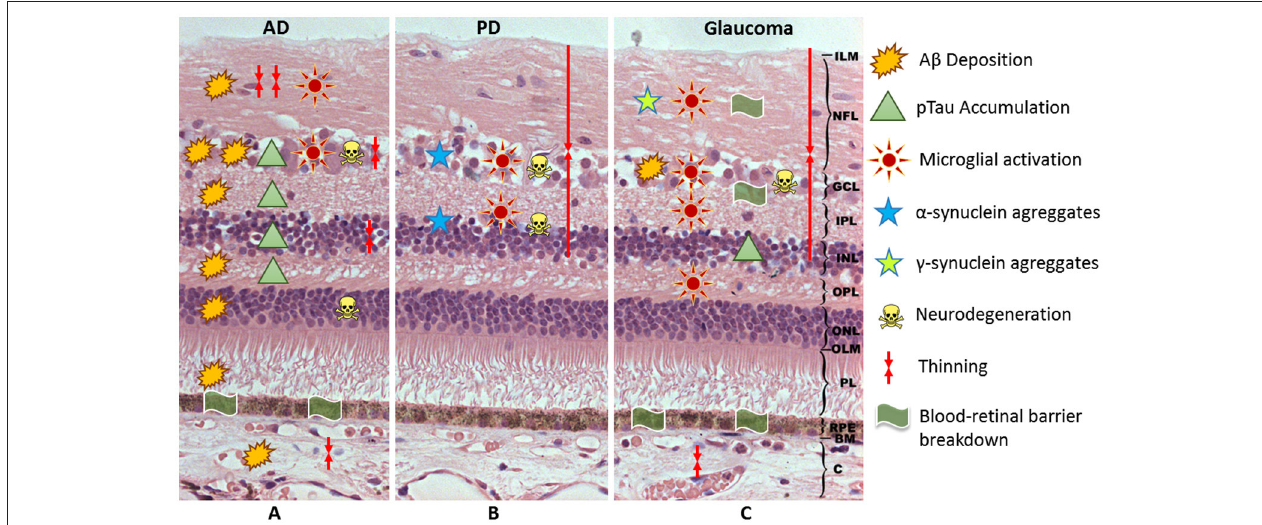
FIGURE 1 | Schematic representation of the hypothetical events associated with the neuroinflammation in AD (A) , PD (B) , and glaucoma (C) . AD, Alzheimer’s Disease; PD, Parkinson’s Disease; ILM, inner limitant membrane; NFL, nerve fiber layer; GCL, ganglion cell layer; IPL, inner plexiform layer; INL, inner nuclear layer; OPL, outer plexiform layer; ONL, outer nuclear layer; OLM, outer limitant membrane; PL, photoreceptor layer; RPE, retinal pigment epithelium; BM, Bruch membrane; C, choroid; A β , beta-amyloid; pTau, phosphorylated tau.